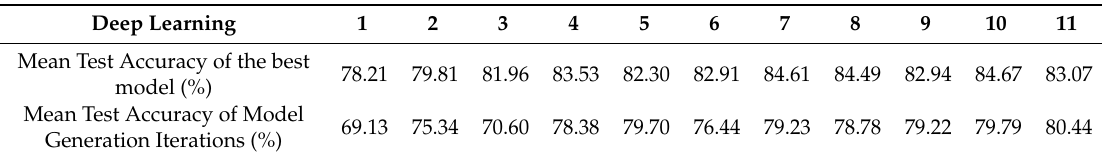
Table 2. Deep-learning test accuracy results (1 / 2).